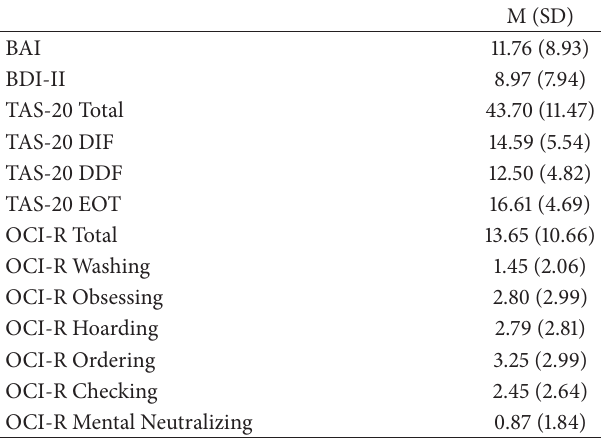
Table 1: Means (standard deviations) on the BAI, BDI-II, TAS-20, and OCI-R ( 𝑛 = 425